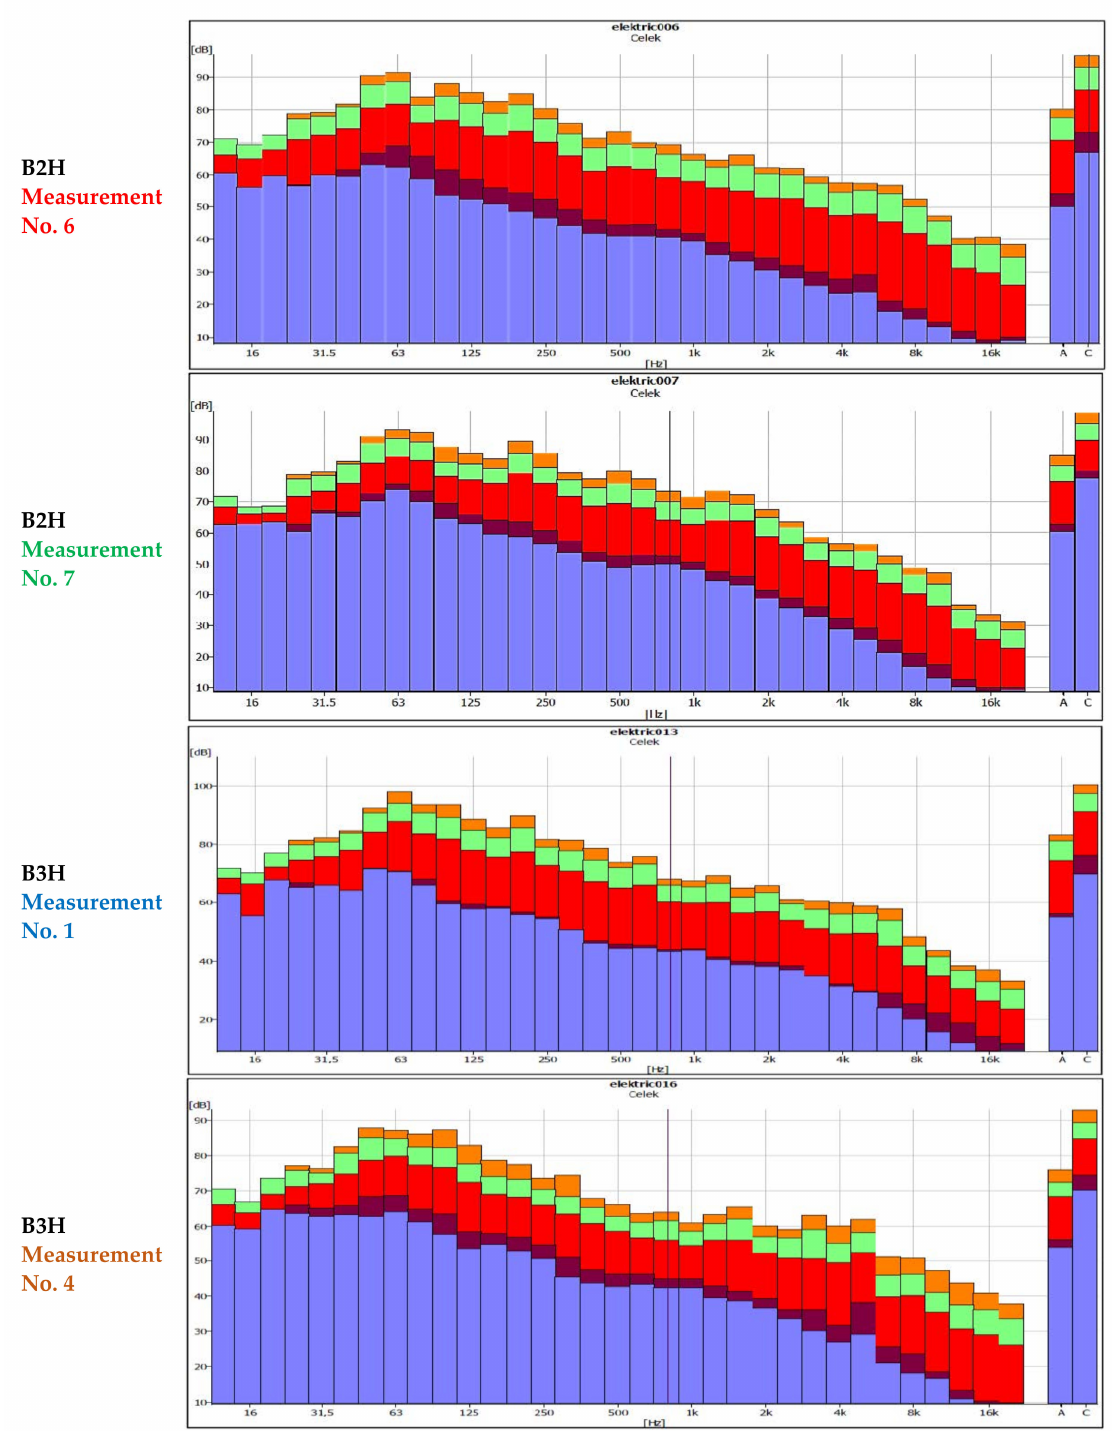
Figure 17. The 1/3 octave frequency spectrum band of noise level values of selected measurements (from above LZF max , LZS max , LZ eq , LZS min , LZF min )